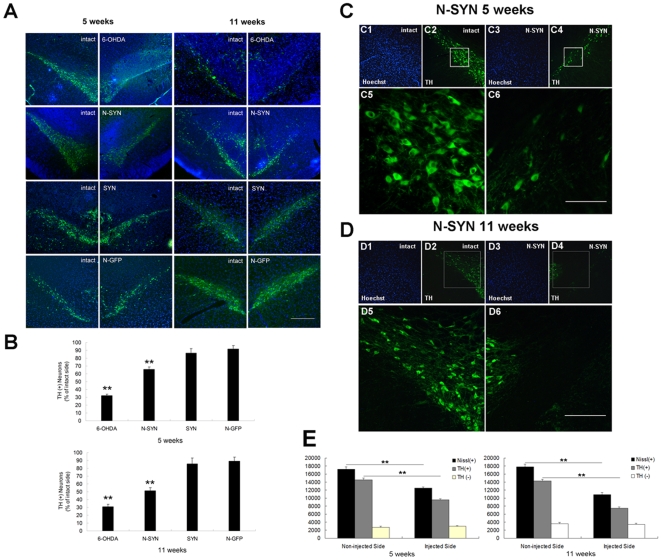
Ipsilateral DA neuron lesions in the SNpc after N-SYN infusion.(A) Representative rat coronal sections showing populations of TH-positive DA neurons in the SNpc 5 weeks and 11 weeks after ipsilateral infusion of 6-OHDA, N-SYN, SYN or N-GFP. Compared to the 6-OHDA as well as to the N-SYN groups, DA neurons in the SYN and N-GFP groups were relatively spared. TH, green; Hoechst, blue. TH-positive DA neurons in the SNpc were more vulnerable to N-SYN than SYN or N-GFP treatment (A, B). (B) Histograms showing the percentage of TH-positive DA neurons on the injected side relative to that on the intact side 5 weeks and 11 weeks after rats were ipsilaterally infused with N-SYN, SYN, 6-OHDA or N-GFP. The percent of TH-positive neurons from both infused and control sides of the SNpc were severely reduced in the 6-OHDA treated group (32.4±1.5% at 5 weeks; 30.7±3.0% at 11 weeks) and the N-SYN treated group (65.5±3.0% at 5 weeks; 51.3±4.0% at 11 weeks), but were mildly reduced in the SYN-treated group (86.6±5.4% at 5 weeks; 85.5±7.7% at 11 weeks). (C) and (D) Representative rat coronal sections showing a substantially reduced population of DA neurons in the SNpc 5 (C) and 11 (D) weeks after ipsilateral infusion of N-SYN. C5, C6, D5 and D6 show high magnification views of the boxed area in C2, C4, D2 and D4, respectively. Hoechst staining (blue; C1, C3, D1 and D3) was conducted to rule out the possibility that the reduction in TH-positive DA neurons was due to a reduction in the total number of cells in the detection area. (E) Further quantification of Nissl-positive and TH-positive neurons on both ipsi- and contralateral sides of SNpc in N-SYN group. Scale bars: (A), 0.5 mm; (C), 50 µm; (D), 100 µm. Values represent mean ± SEM; **, p<0.01.